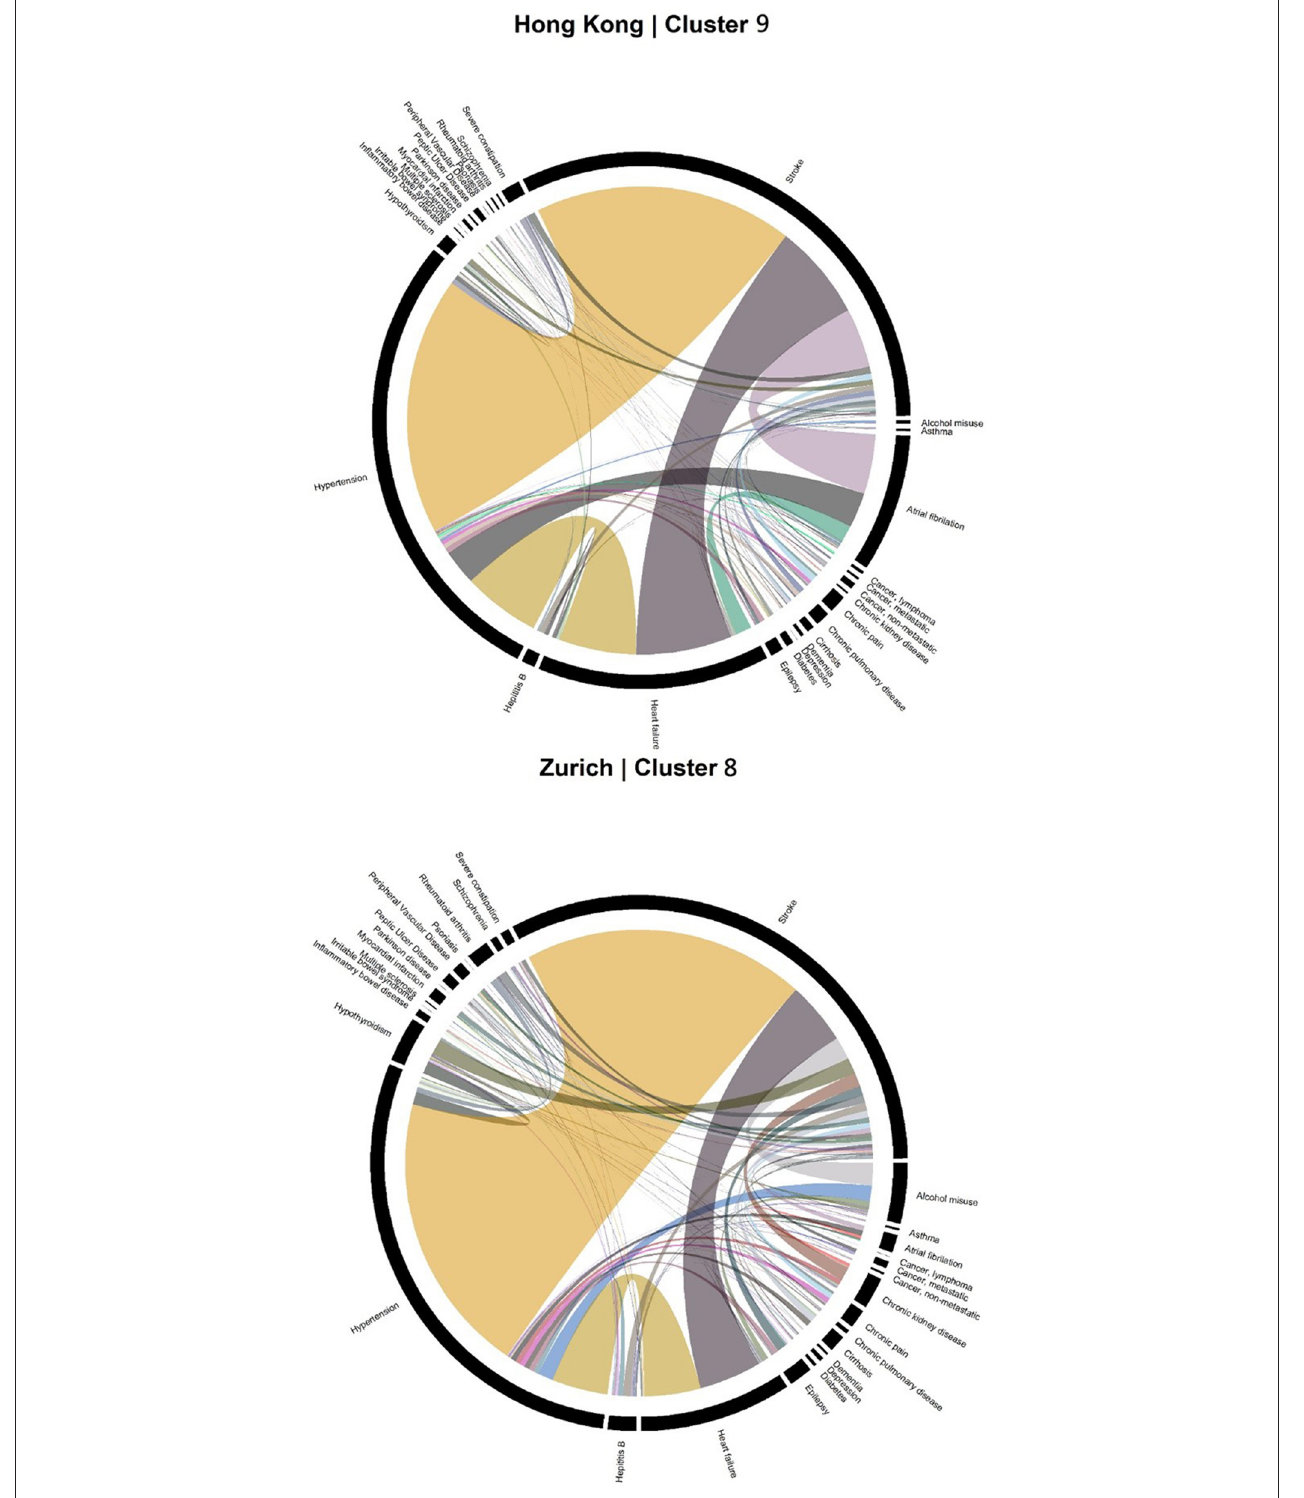
FIGURE 6 | Chord diagrams showing the frequencies of disease dyads among inpatients from Cluster H9 of Hong Kong and Cluster Z8 of Zurich (stroke clusters).